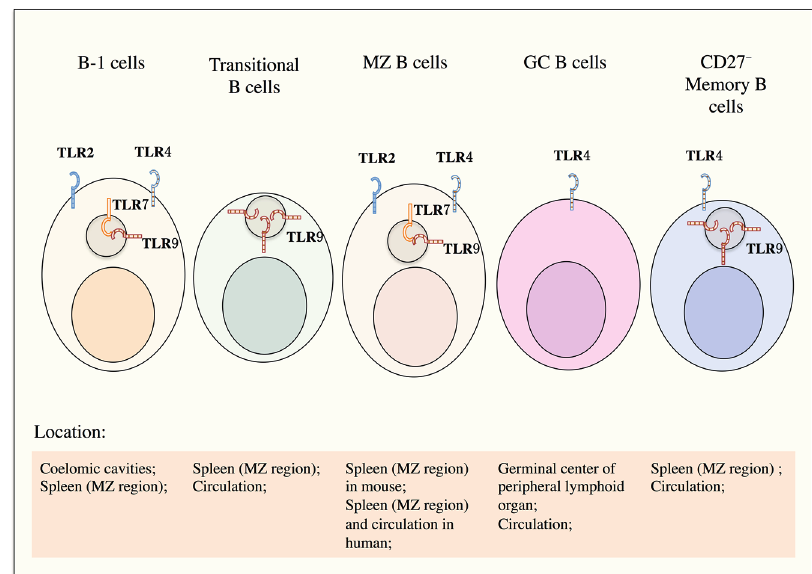
Figure 1. TLR signals in B cell subpopulations. B-1 cells, transitional B cells, marginal zone B cells, germinal center B cells as well as memory B cells are responsive to TLR ligation. B-1 cells are highly sensitive to the ligation of TLR, 2, 4, 7 and 9. CpG ligates the TLR9 in transitional B cells. Marginal zone B cells are more sensitive to the ligation of LPS and CpG. Germinal center B cells respond to TLR4 ligation whereas TLR9 is highly expressed in CD27 − memory B